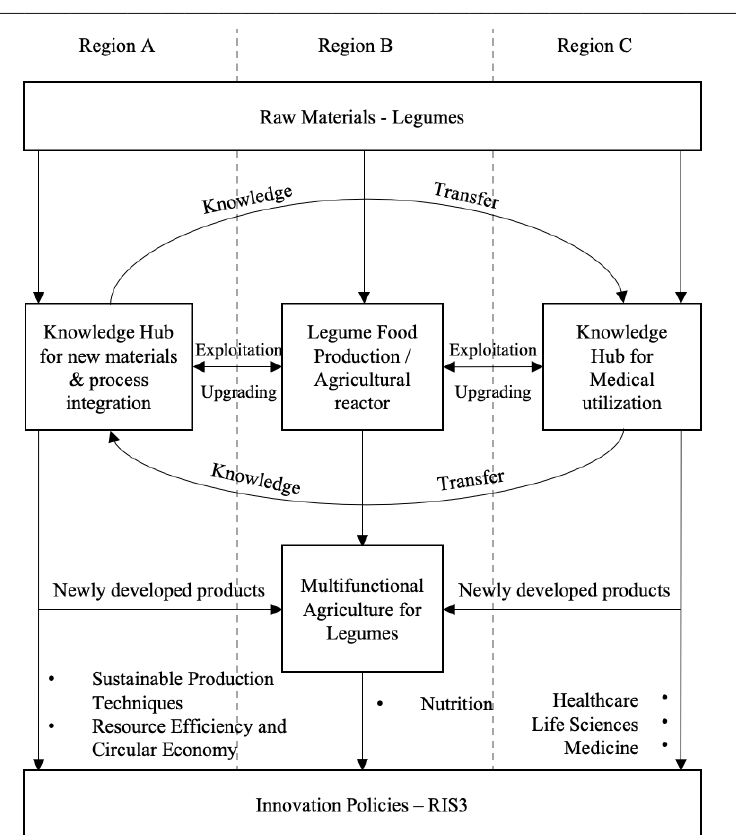
Fig. 2. Cross-border cooperation concept as use case for legume multifunctional agriculture and impacts on RIS3 (compiled by